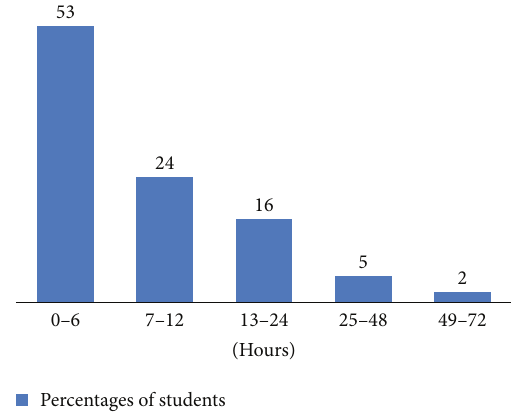
Table 1: Age distribution ( 𝑛 = 93 ).